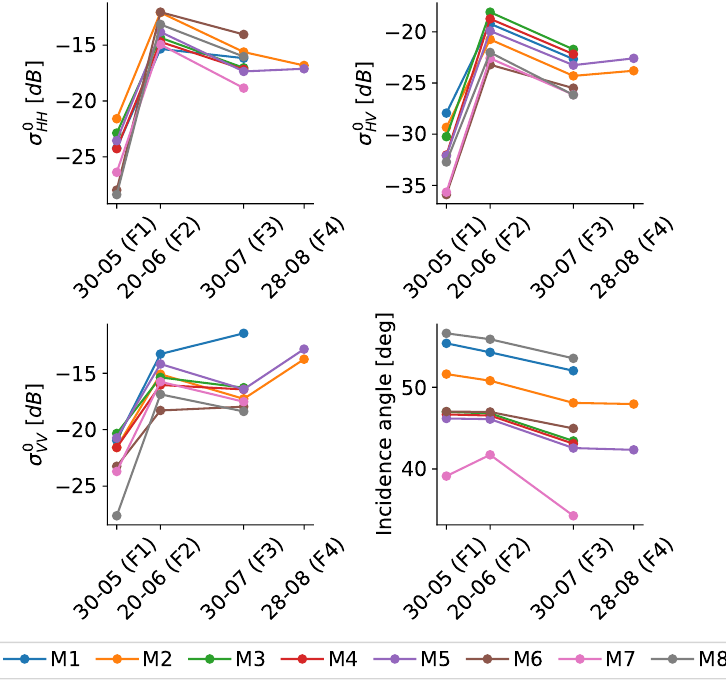
Figure 2. Time series of average L-band backscattering coefficient σ 0 and incidence angle acquired from an airplane during the BELSAR-Campaign. M1 to M8 designate the maize fields in which data were